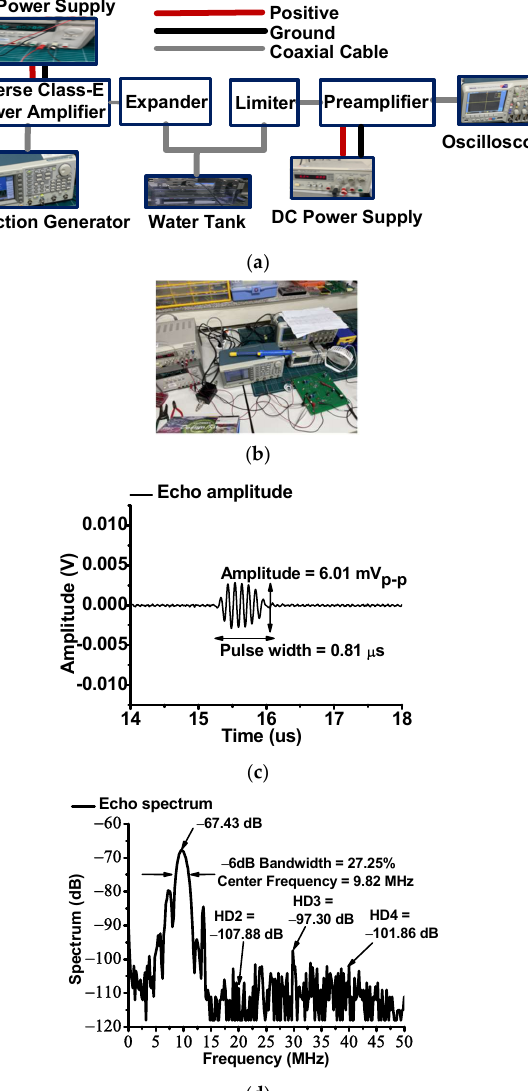
Figure 8. ( a ) Measurement setup and ( b ) photo of the pulse-echo response with designed inverse Class-E power amplifier and ultrasound transducer. The measured echo signal amplitude and spectrum in the ( c ) time and ( d ) frequency domains when using the designed inverse Class-E power amplifier and ultrasound